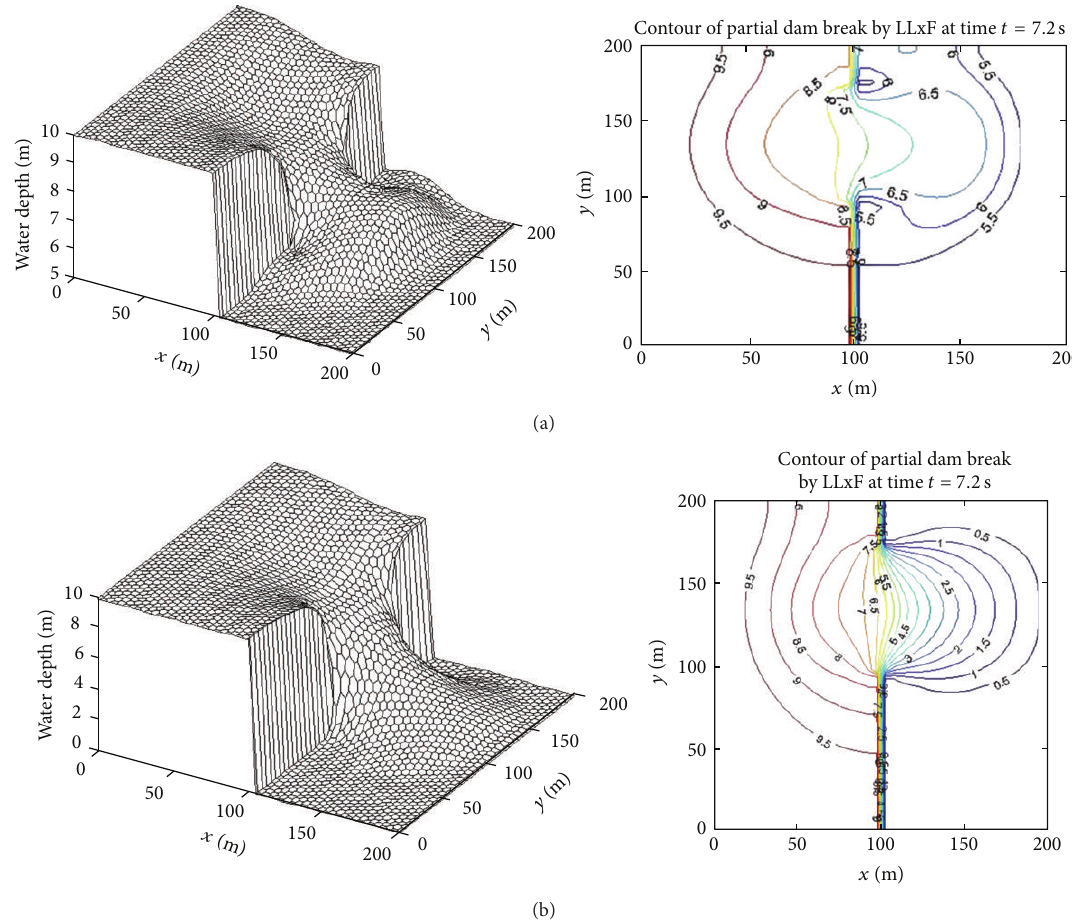
Figure 8: 2D asymmetrical partial dam break test and in a frictionless horizontal domain at 𝑡 = 7.2 s obtained by V-Break. (a) Wet bed and (b) dry bed.